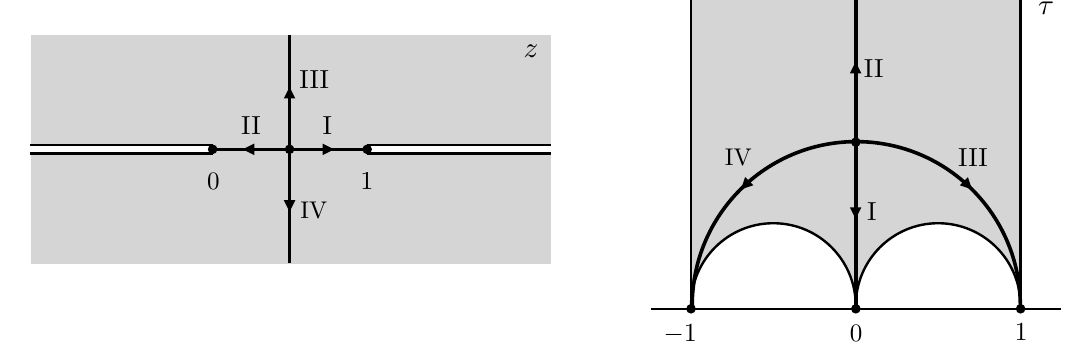
Figure 5 . Left: contour integral de(cid:12)nition of the analytic extremal functional in the z -plane, see (5.24), (6.59). Right: Viazovska’s contour integral de(cid:12)nition of the magic functions, see (6.57). The two de(cid:12)nitions are related by the transformation z = (cid:21) ( (cid:28) ). The contours labelled by the same Roman numerals get mapped to each